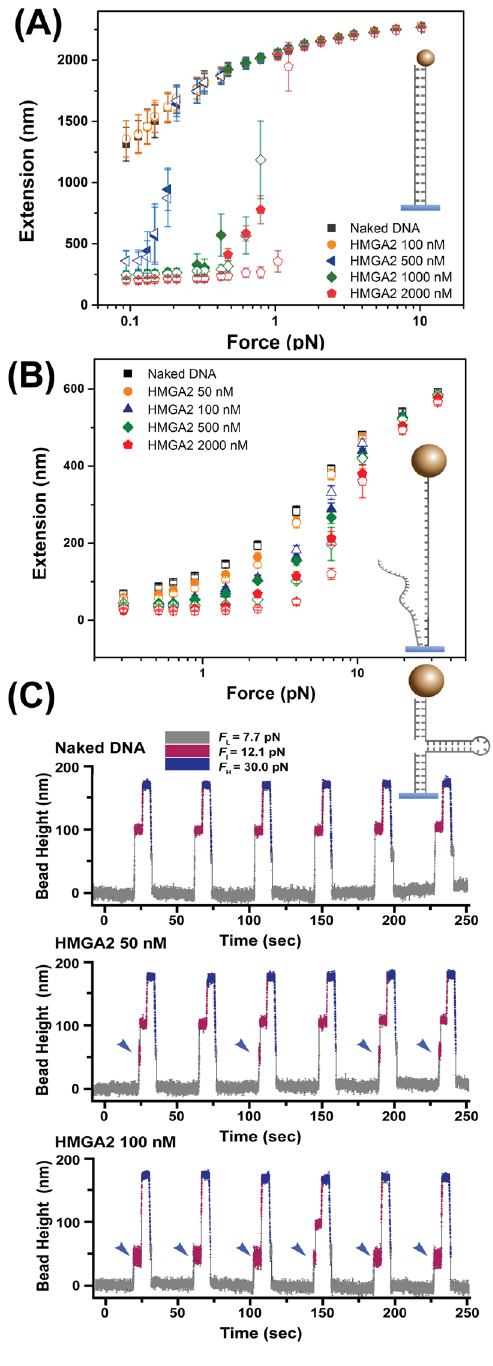
Figure 2. Binding of HMGA2 to ds DNA, ss DNA, and forked DNA. ( A , B ) Representative force-extension curves of a torsionally unconstrained ds DNA ( A ) and ss DNA ( B ) obtained in a force-decrease (solid data points) scan and a following force-increase scan (hollow data points) in different HMGA2 concentrations. Error bars are the standard deviation values of the DNA extension fluctuation over the recording time windows. ( C ) Representative time traces of bead heights of DNA fork during six force cycles at varied HMGA2 concentrations. The bead height at F L is set as zero. In the absence of HMGA2 (top panel), after force jumping from F L to F I , the bead height changed immediately to the level corresponding to that of unfolded hairpin (Fig. S4), indicating rapid hairpin unfolding at this force. In the presence of 50 nM (middle panel) or 100 nM HMGA2 (bottom panel), HMGA2 binding resulted in increased lifetime of the hairpin at F I (marked by blue arrows) compared to the case in the absence of HMGA2 binding. In the measurements for ( A , B ), the change of DNA extension could be determined. In the measurement for ( C ), due to the significant influence of bead rotation during force change, accurate DNA extension change could not be determined. Therefore, the bead height change was used to present data (see details in Methods: “magnetic tweezers